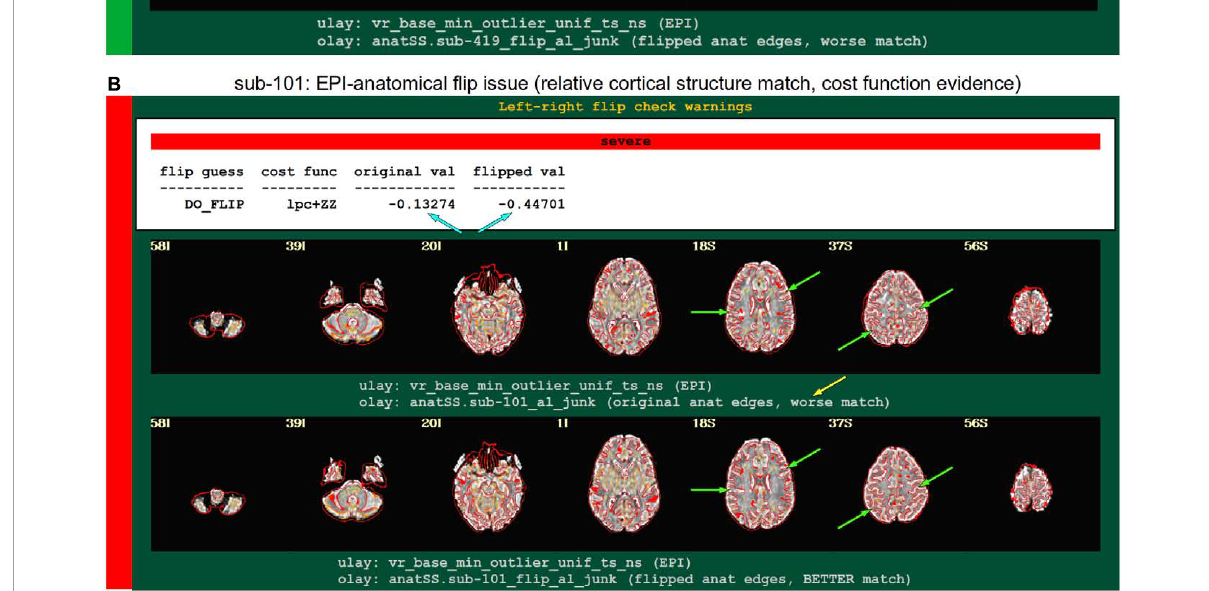
FIGURE8 APQUAL examples for the “warns” QC block: Warnings created during processing, here for possible left-right flipping between the EPI and anatomical volumes. The warning field contains the APQUANT evaluation, based on cost function comparison (blue arrows), with its comment on the original (yellow arrow) and flipped EPI volumes. Importantly, images of each alignment result within the test are shown, for visual verification of the results. (A) The structures of the original EPI match well with the anatomical volume (and those of the flipped version do not), suggesting consistency. (B) The structures of the original EPI do not match well with the anatomical volume, while those of the flipped version do, suggesting inconsistency in the